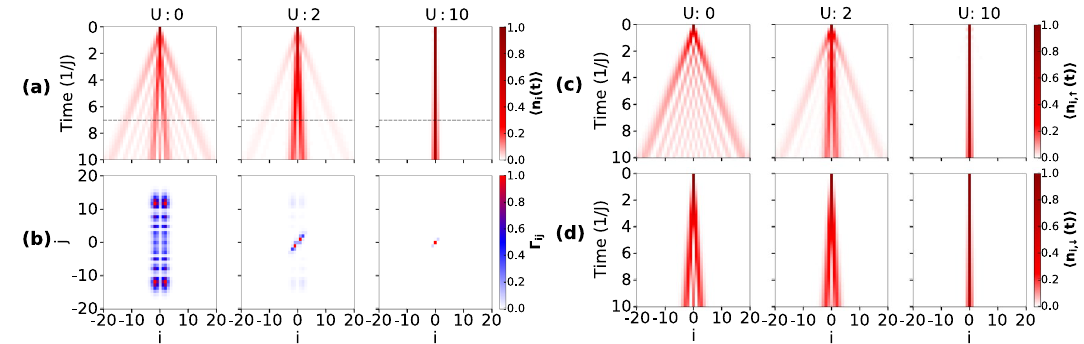
Figure 2. Shows the QW of two particles with the initial state given in Eq. (5) and δ = 0.2 . ( a ) Shows the time evolution of the normalized on-site density for different values of U . ( b ) Shows the normalized correlation functions Ŵ ij at time t = 7 J − 1 , which correspond to the dashed lines in ( a ). ( c , d ) shows the on-site density evolution of ↑ particle and ↓ particle respectively corresponding to the QW shown in ( a